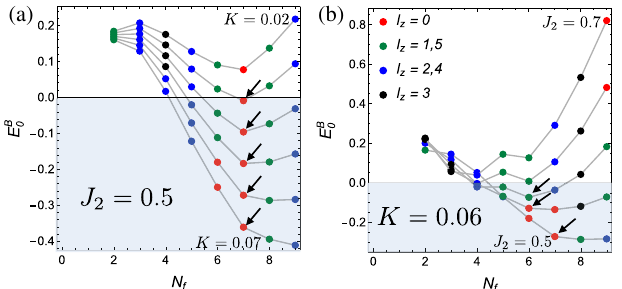
FIG. 4. Phase diagrams. (a) Parameters for which stable multiple-spin bound states are found in a ferromagnet; see Fig. 3. These states fulfill Eq. (4) and are thus stable against “ quantum evaporation ” of magnons into the ferromagnet. The dots denote parameters for which the binding energy per flipped spin has a minimum as a function of N f . The red dots denote parameters where additionally the bound state with the lowest binding energy per flipped spin obeys the skyrmion selection rule, Eq. (11). Dashed line, E m ¼ 0 ; see text. (b) A magnetic field is needed to min stabilize the ferromagnetic and the skyrmion phase. Below the red dot-dashed line the ferromagnet (FM) is energetically unstable with respect to single spin flips. In the light gray region the ferromagnet is the ground state but skyrmions exist as metastable excitations. In the dark shaded region the system can minimize its energy by the proliferation of skyrmions and a skyrmion lattice is expected to form. The black dashed line is determined from the condition that the skyrmion with the lowest energy reaches the largest number of spin flips, N f ¼ 9 , in our